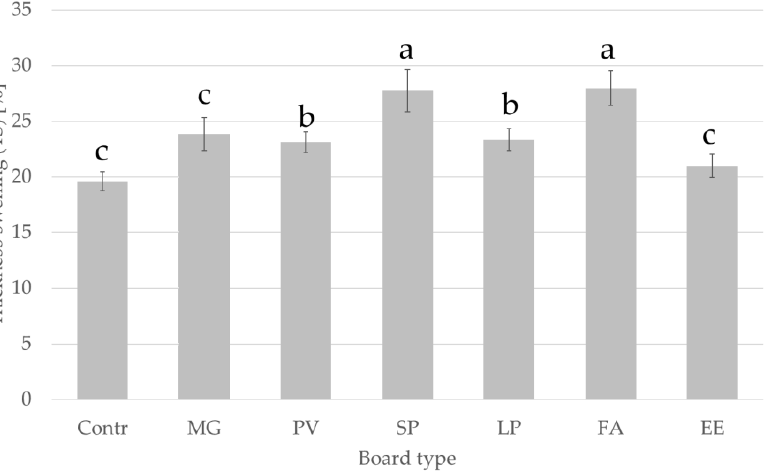
Figure 5. Thickness swelling of manufactured panels after 24 h. Abbreviations used: contr.—control